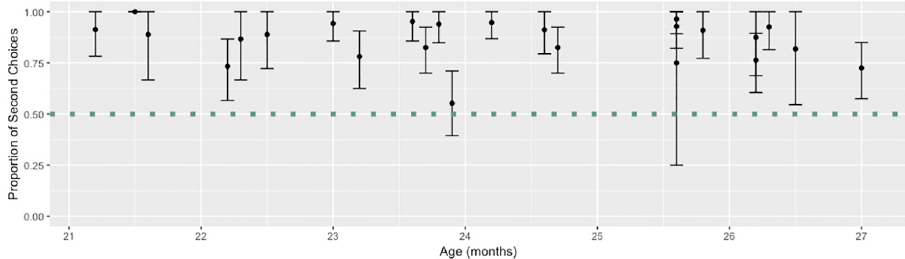
Fig 2. Robust recency bias across ages in Experiment 1. Each dot represents an individual’s proportion of second choices during the trials in which they responded verbally. The error bars depict 95% confidence intervals. The dotted line represents chance. Twenty-two of the twenty-four participants exhibited significantly more second-choice responses than would be predicted by chance.